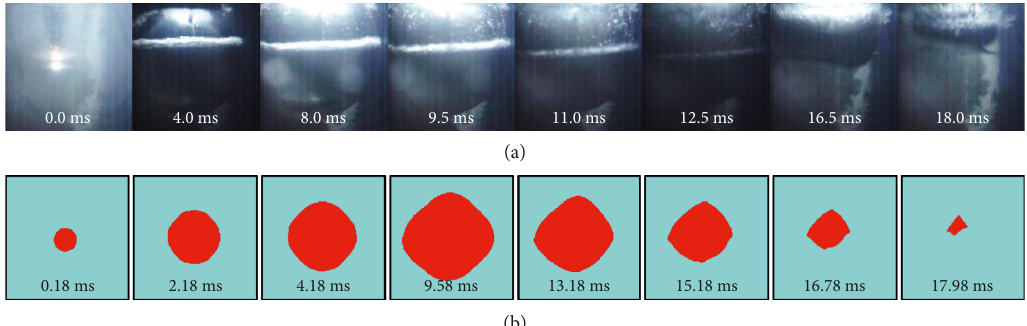
Figure 19: Bubble movement in the first period of (a) UE-Exp-04 and (b) UE-Num-11.